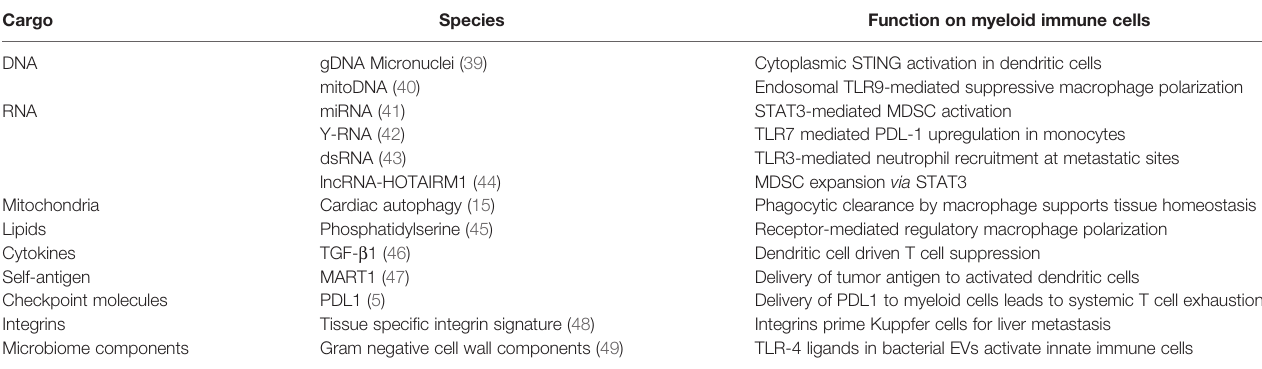
TABLE 1 | Examples of EV cargo effects on signalling in myeloid cells.